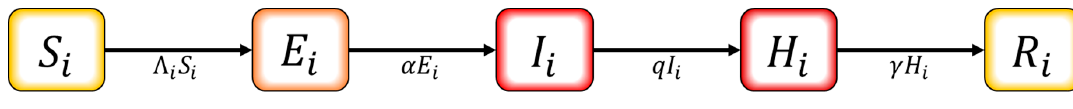
Figure 3. Contact matrix for a policy of school closure and no social distancing in Seoul and Gyeonggi province.